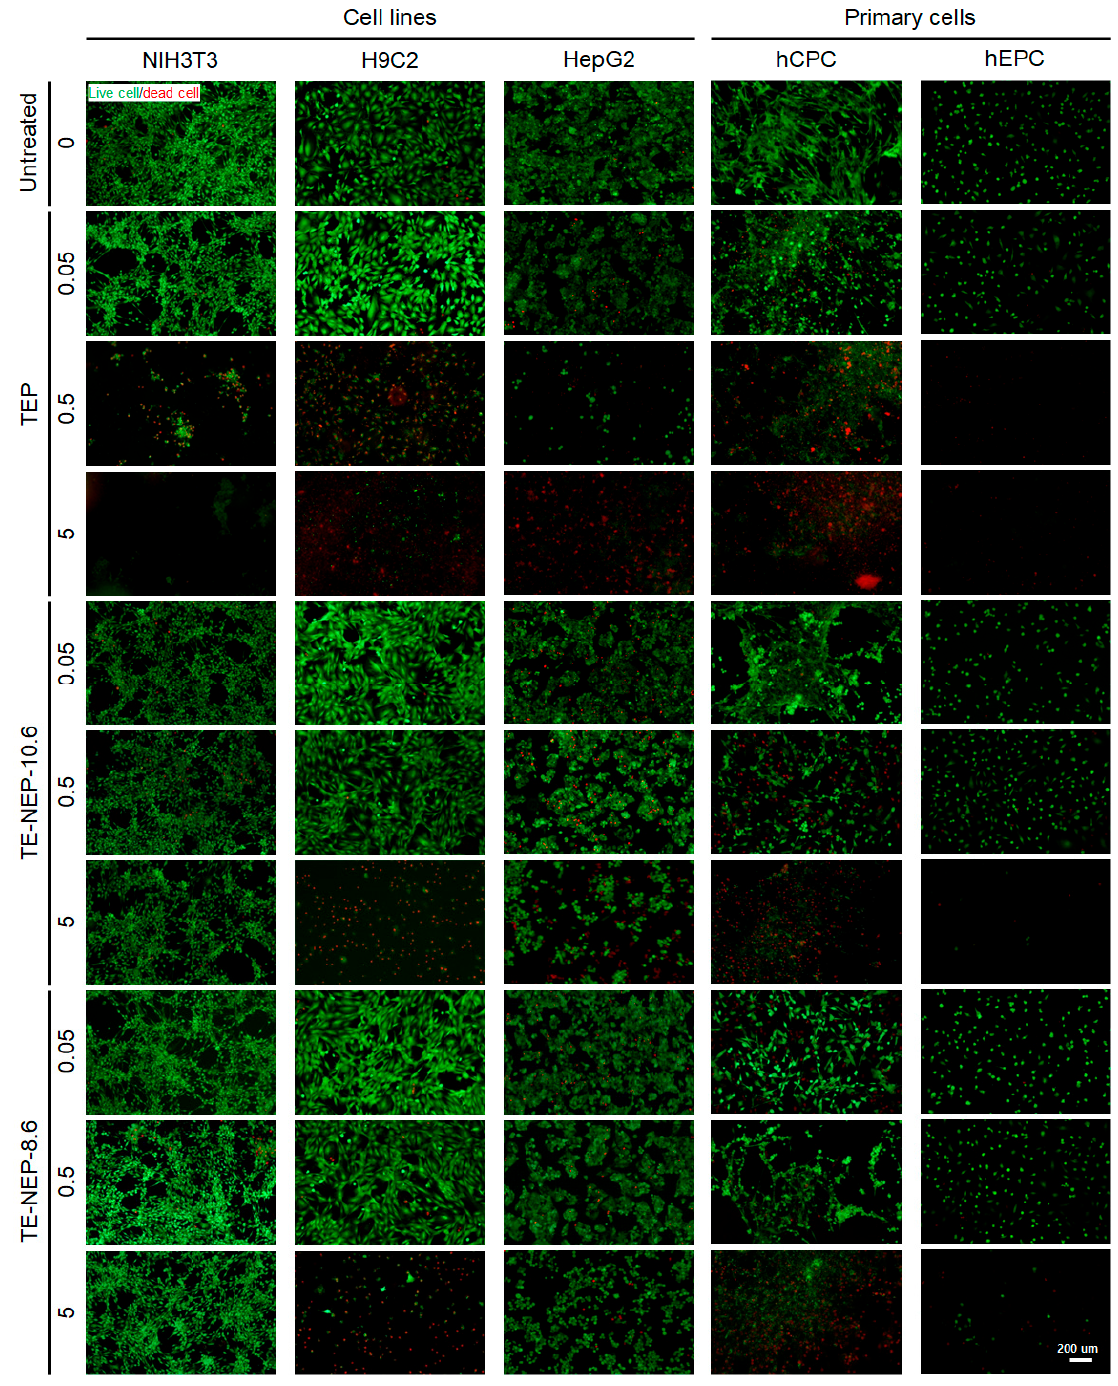
Figure 4. Representative fluorescence live/dead images of NIH3T3, H9C3, HepG2, hCPC, and hEPC. Each cell was stained with calcein-AM (green)/ethidium homodimer (red) LIVE/DEAD assay after the sample (TEP, TE-NEP10.6 and TE-NEP-8.6) treatment (24 h). Scale bar = 200 μ m.